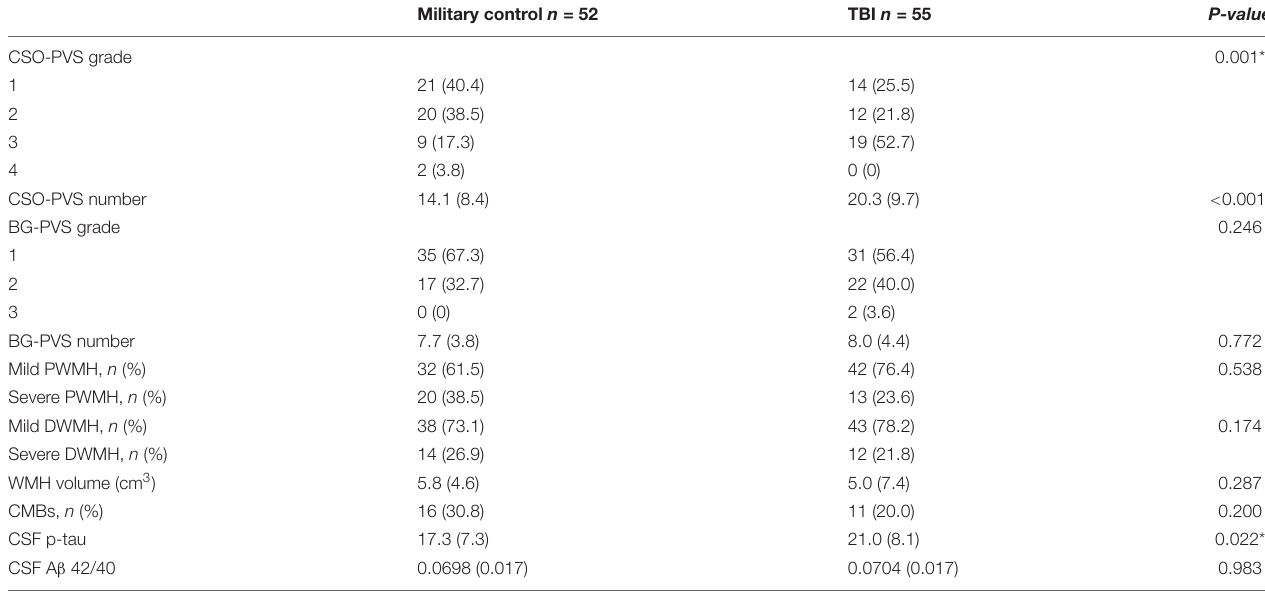
TABLE 2 | MRI findings and CSF markers in Vietnam War veterans with and without a history of traumatic brain injury (TBI). Military control n = 52 TBI n = 55